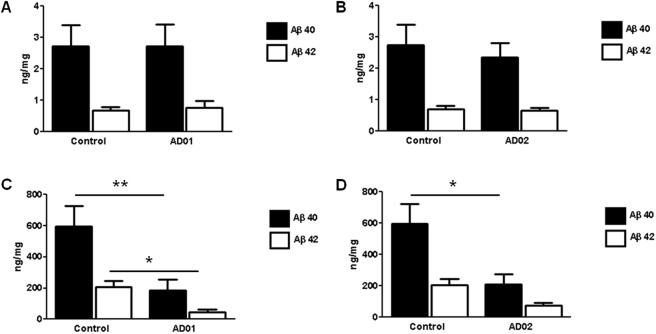
AFFITOPE immunization reduces cerebral amyloid levels in Tg2576 mice (ELISA).Groups of Tg2576 mice (n = 10/group) received 6 monthly injections of KLH/ALUM or AD01-, AD02-conjugate vaccines. Brains were isolated, 8 weeks after the 6th immunization, extracted and soluble and insoluble brain fractions were subjected to Human Aß40 and Human Aß42 ELISA (EMD-Milipore, USA) analysis. Neither AD01- (A) nor AD02 treated animals (B) showed a significant change of soluble Aß1-40 and Aß1-42 following immunotherapy as compared to control immunized animals. Insoluble Aß was reduced significantly following immunotherapy. C) AD01 treated animals showed a 69% reduction of Aß1-40 levels (p = 0.005) and a 78% reduction of Aß1-42 (p = 0.015), respectively. D) For AD02 a 60% reduction of Aß1-40 (p = 0.033) and a 62% (p = 0.056) reduction of Aß1-42 could be detected. Results are expressed as average ± SEM and are given as ng/mg total protein. Black bars represent Aß1-40 and white bars represent Aß1-42 values. Asterisks in C+D indicate statistical significant difference (*…p<0.05, **…p<0.01);